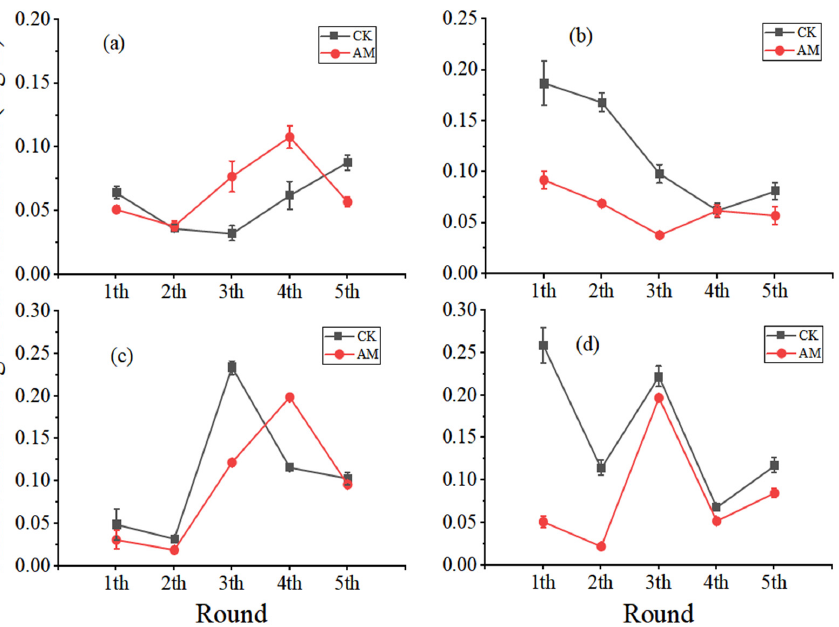
Figure 3. Variation in runoff ammonium nitrogen loss concentration in different soil troughs under simulated scouring in ( a ) Cynodon dactylon , ( b ) Lotus corniculatus , ( c ) Zoysia japonica , and ( d ) Astragalus sinicus . Error bars represent ± standard errors.